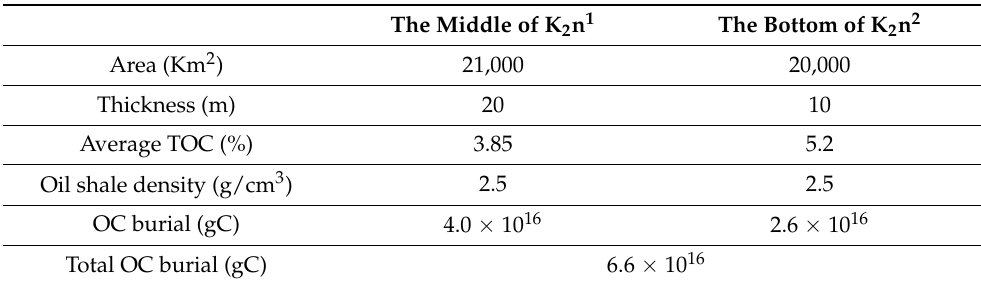
Table 2. Organic carbon burial in two oil shale intervals of Nenjiang Formation in north part of Songliao